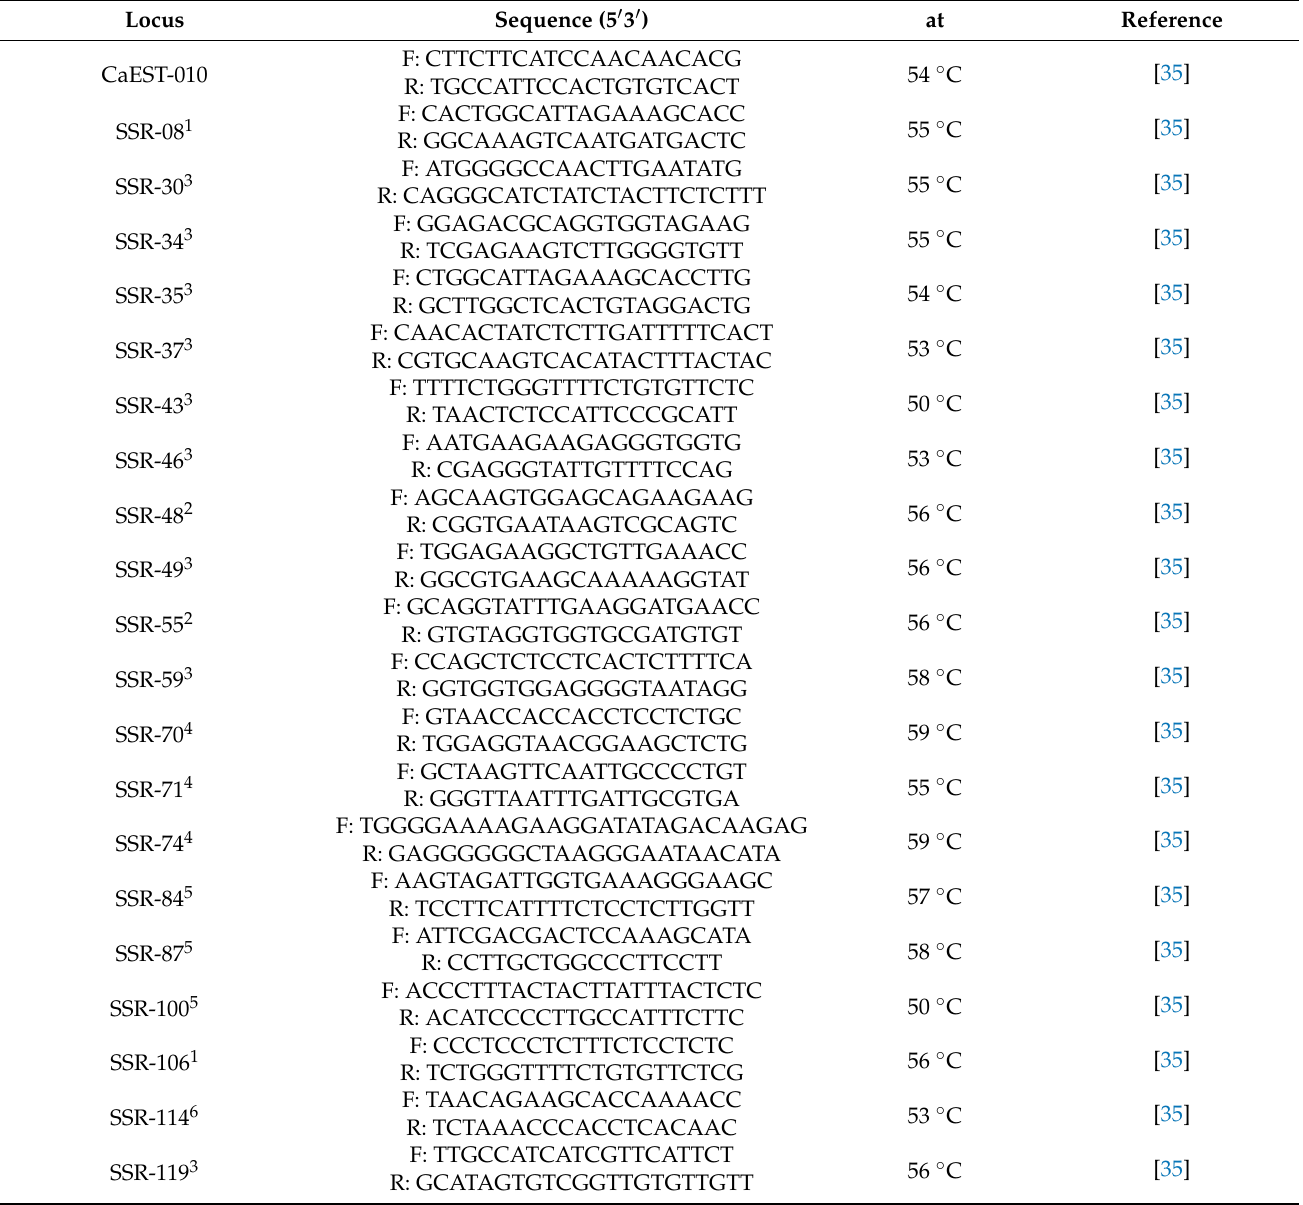
Table 4. Sequence of 21 microsatellite primer pairs used to analyze 44 C. canephora and 1 C. arabica